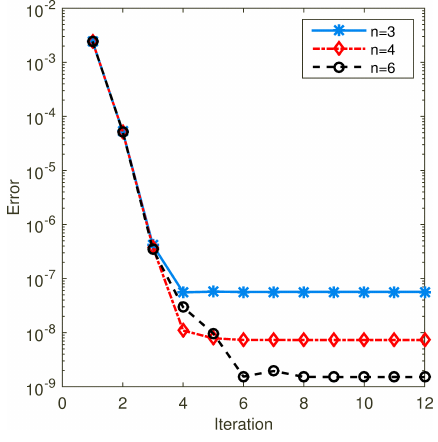
Fig. 5. Convergence behavior of parareal algorithm with 3, 4 and 6 Radau IIa